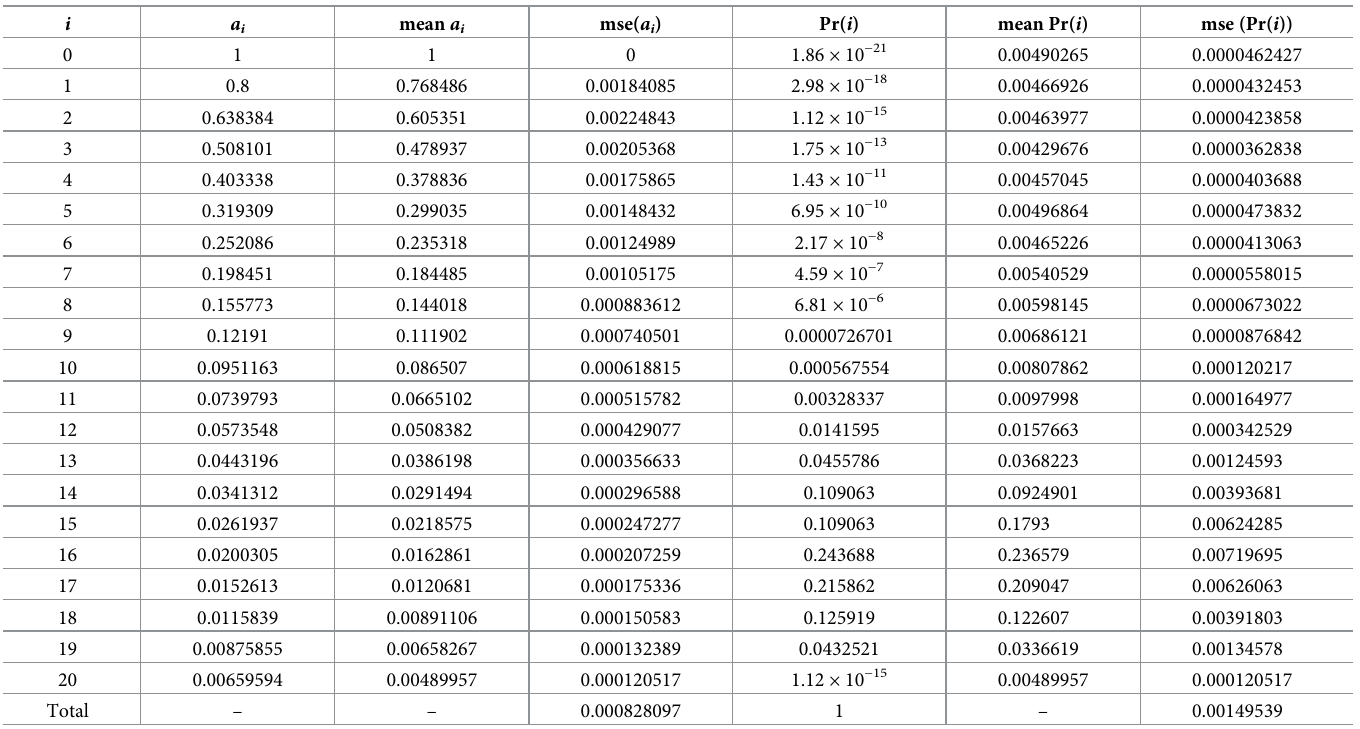
Table 8. Scenario 2. H (100, 80, n ) where n = 5, 10,